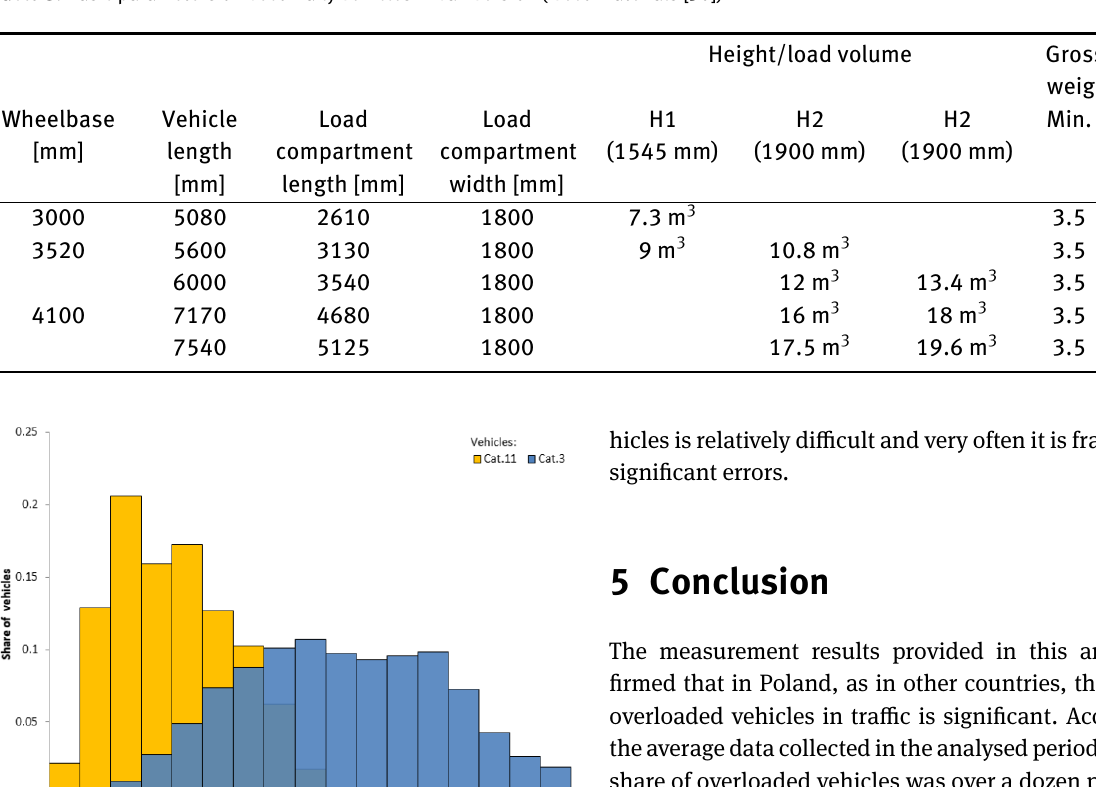
Table 8: Basic parameters of Iveco Daily vehicles in van version (Iveco materials [30])